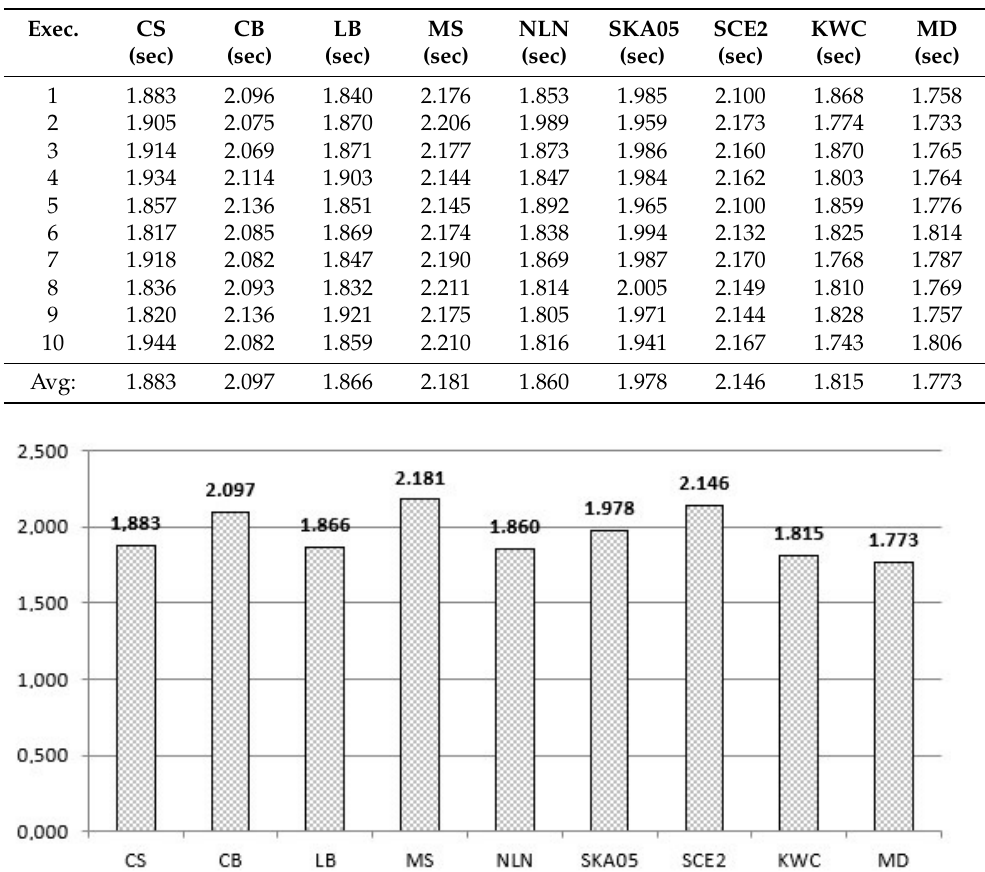
Table 2. Execution times of each algorithm when clipping 10,000,000 lines.